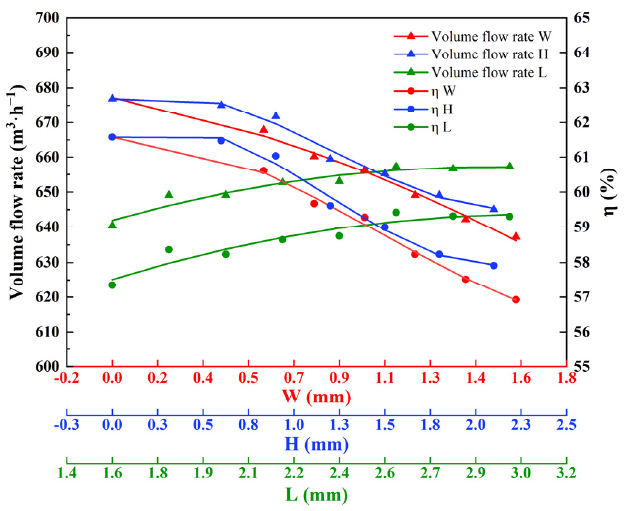
Figure 11. Aerodynamic performance varies with change to basic parameters.